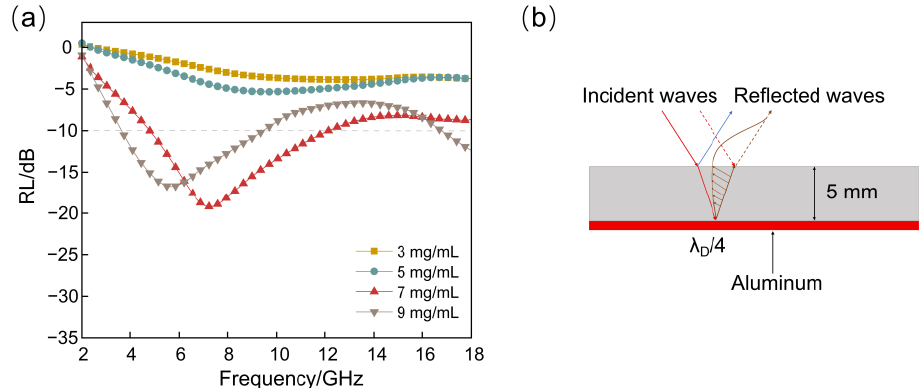
Figure 5. ( a ) Reflection loss of four concentration samples; ( b ) schematic diagram of quarter-wavelength phase extinction of single-layer samples.